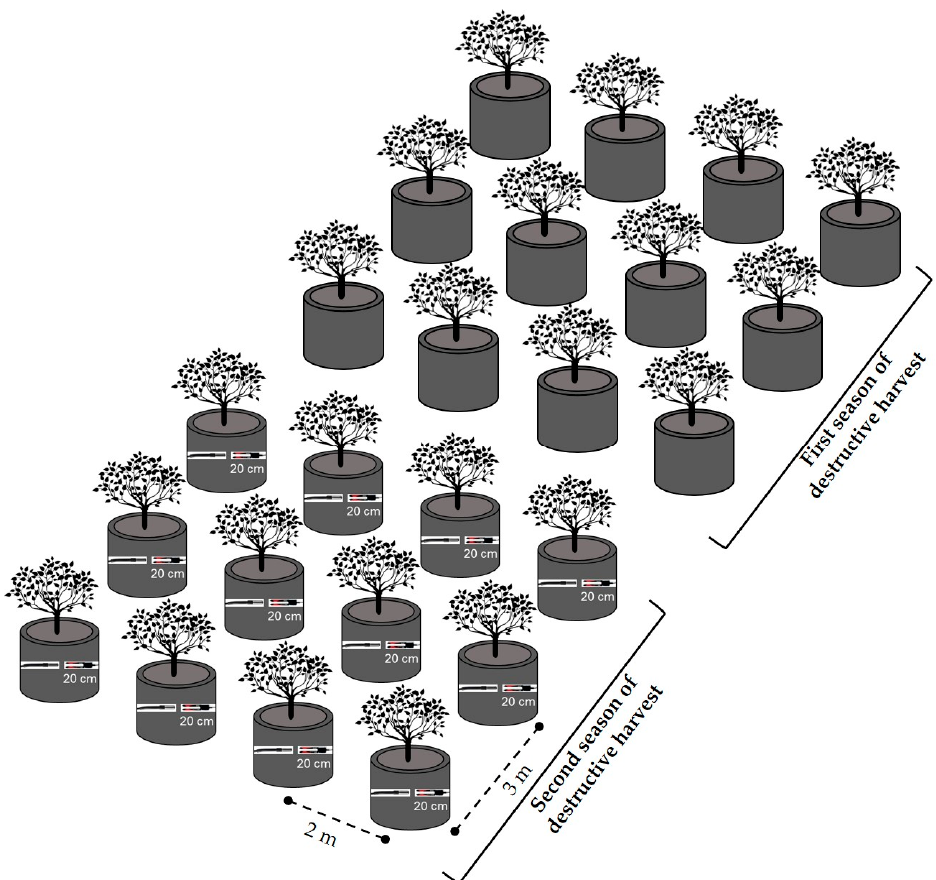
Figure 1. Schematic arrangement of the experimental units on the field.